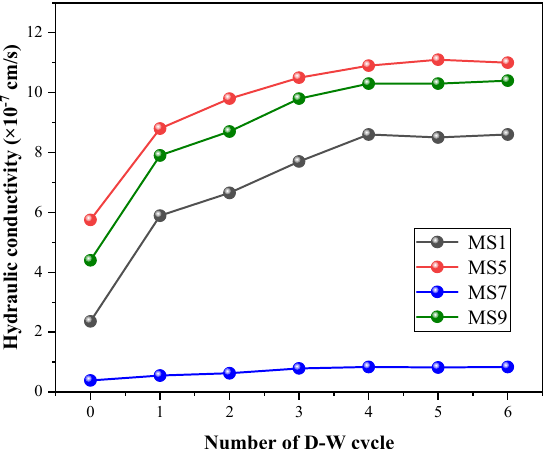
Figure 6. Hydraulic conductivity of modified dredged sludge samples during drying–wetting cy- cles.